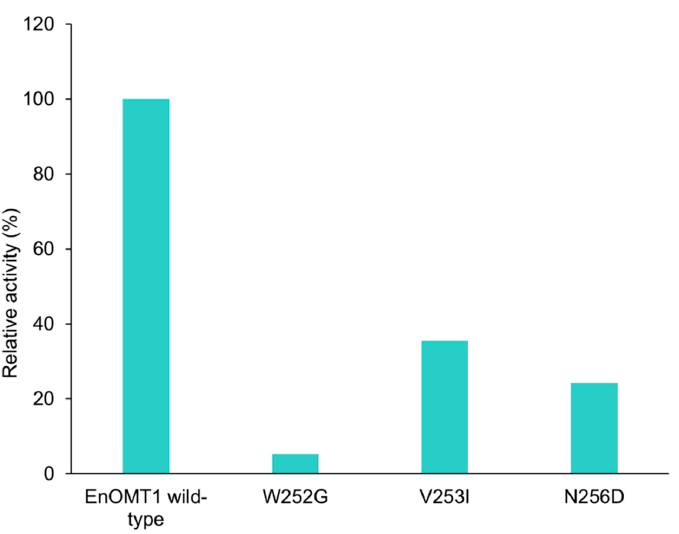
Figure 9. Activity of EnOMT1 single mutant clones (W252G, V253I and N256D) compared to that of wild-type EnOMT1, expressed in terms of the percentage of pinocembrin converted into methylated product.